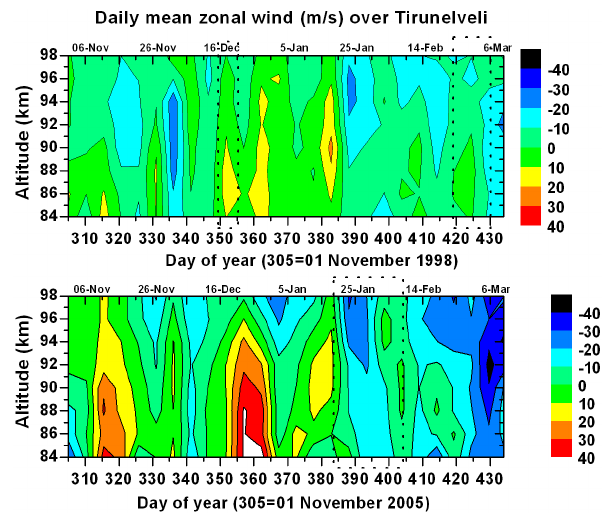
Fig. 4. Daily mean zonal winds for the altitudes 84–98km over Tirunelveli for 1–130 days starting from 1 November 1998 (top panel) and 1 November 2005 (bottom panel). The dotted boxes show the duration of the CEJ